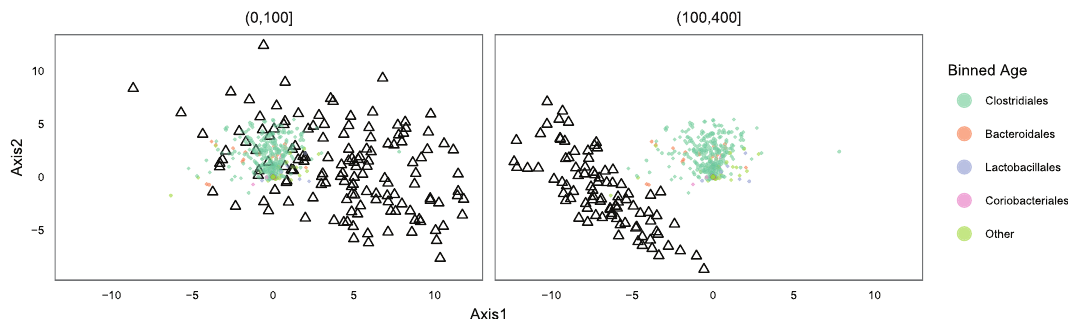
Figure 19. PLS produces a biplot representation designed to separate samples by a response